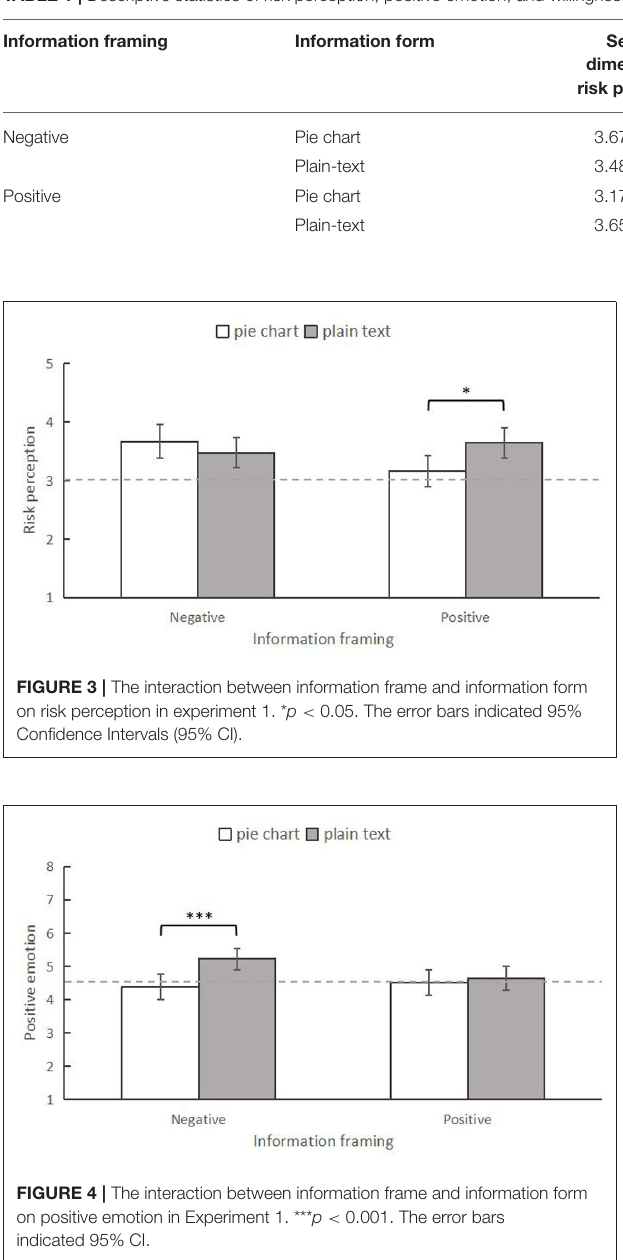
TABLE 1 | Descriptive statistics of risk perception, positive emotion, and willingness to help of participants in different information priming conditions ( M ± SD ).